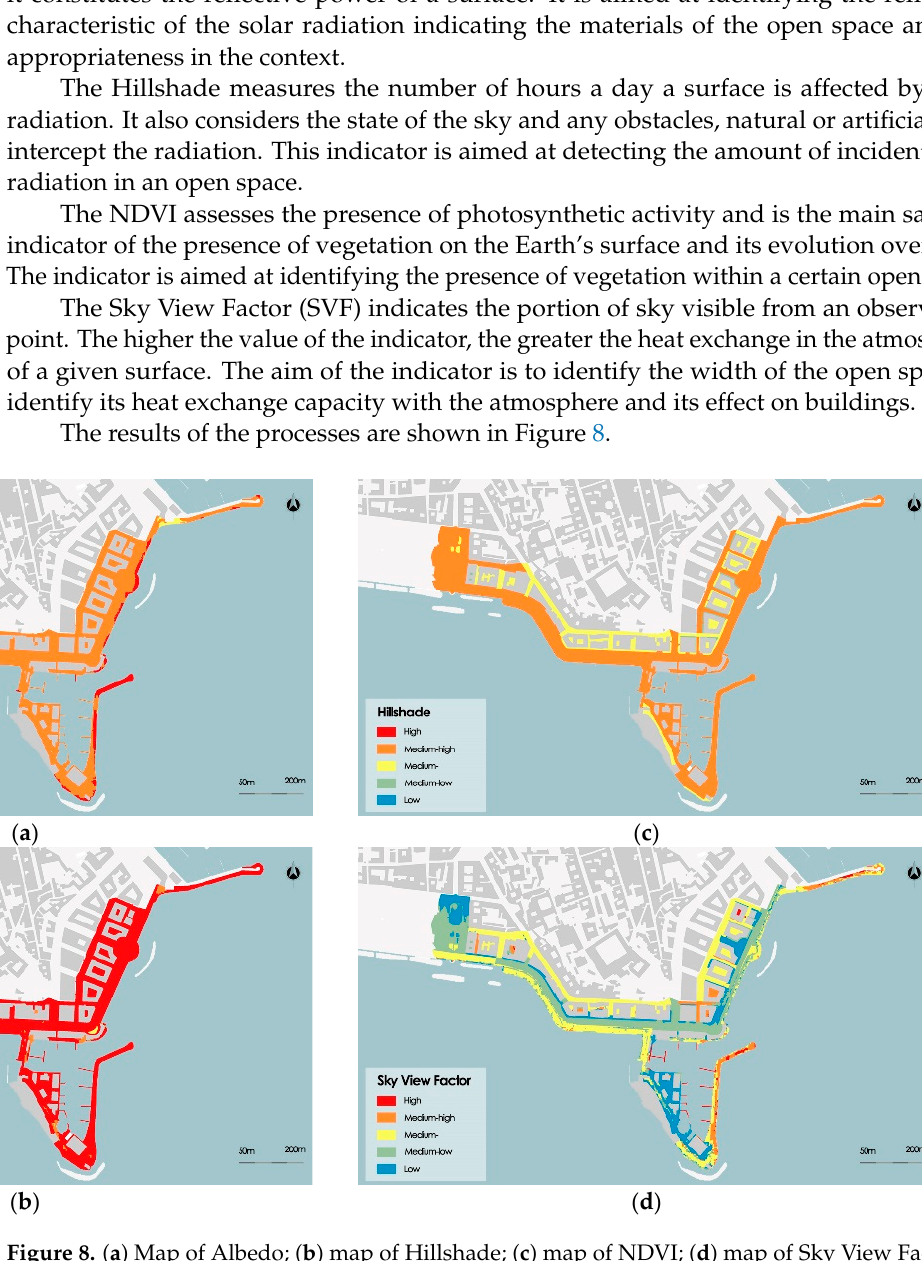
Figure 8. ( a ) Map of Albedo; ( b ) map of Hillshade; ( c ) map of NDVI; ( d ) map of Sky View Factor. To summarise the vulnerability to HWs, each indicator is given a weight, and a weighted average was calculated. The output of the process is shown in Figure 9.